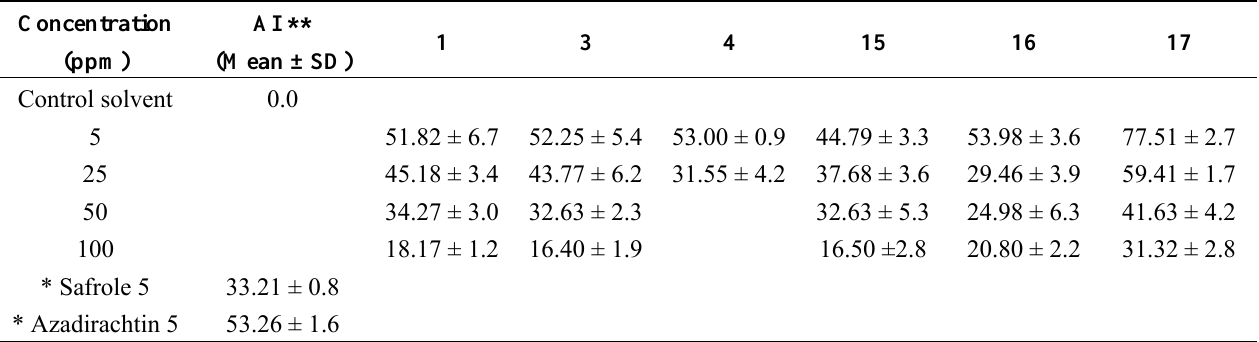
Table 1. Results obtained in antifeedant tests, using different concentrations of compounds on D. melanogaster larvae .